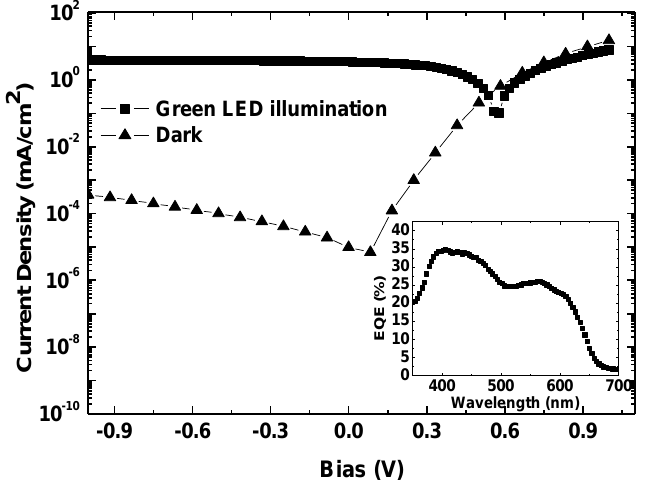
Figure 4. J-V characteristic of the OPD in dark (triangles) and under green- LED illumination (squares). Inset shows OPD external quantum efficiency at 0